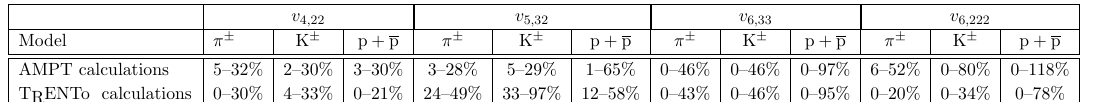
Figure 14 . The comparison between [ v (cid:25) (cid:6) into di(cid:11)erent centrality intervals of Pb-Pb collisions at uncertainties are shown as bars and boxes, respectively.